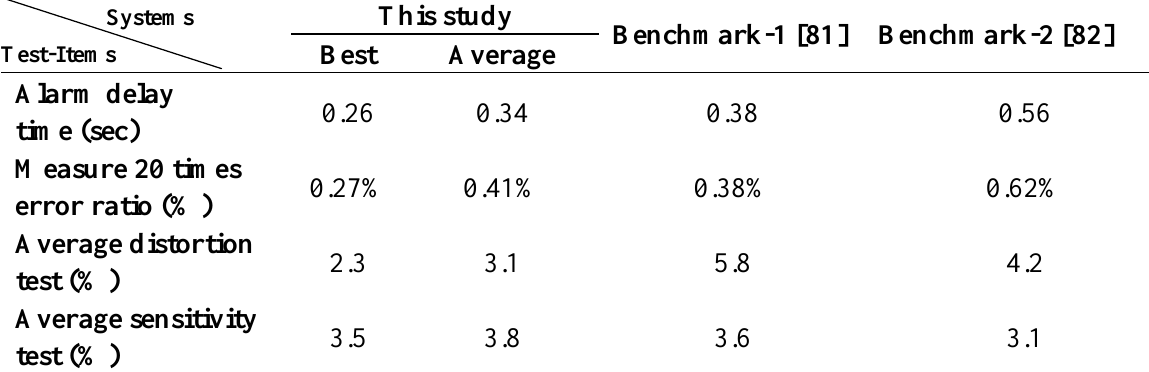
Table 1: Compare existing system with this study at some important tests.